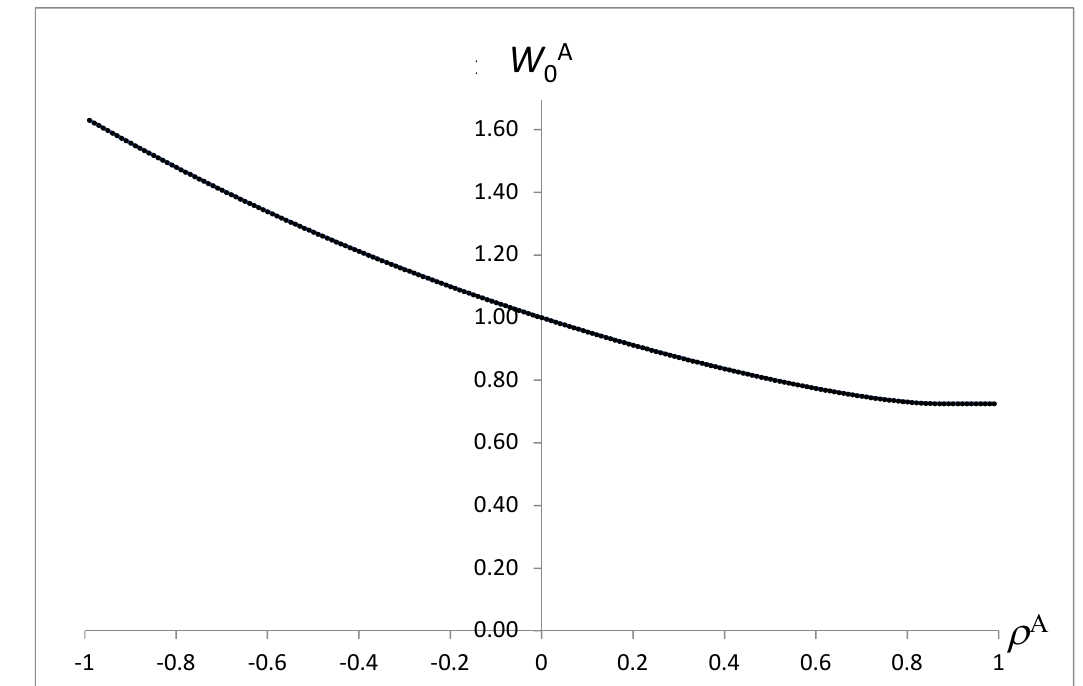
A should be for the firm not to W should be for the firm not to 0 0